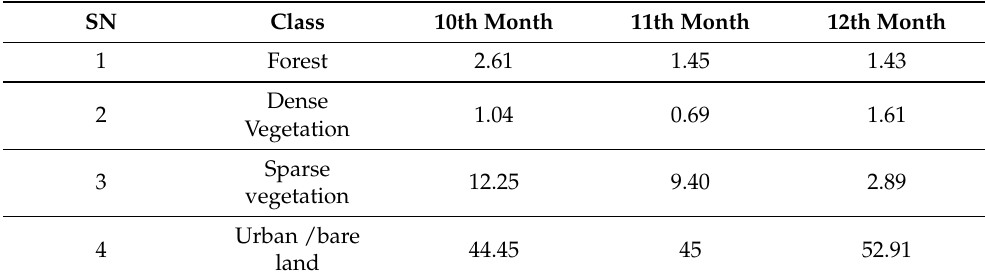
Table 5. The pattern of Land-cover from September to November.